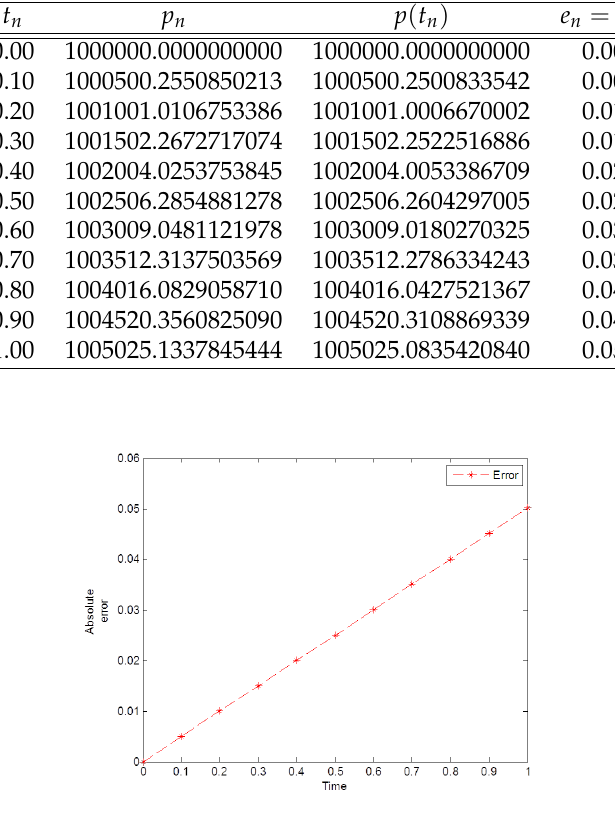
Figure 4. Errors generated via the scheme (40)